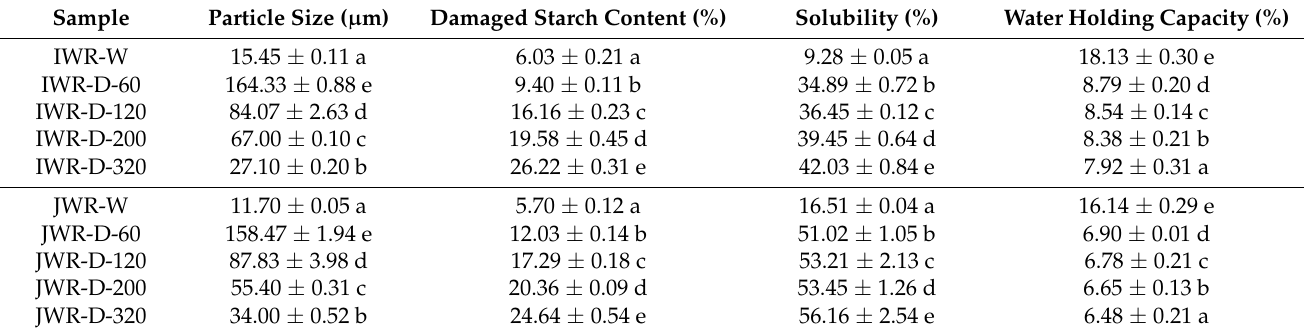
Table 1. Particle size, damaged starch content, water holding capacity and solubility of waxy